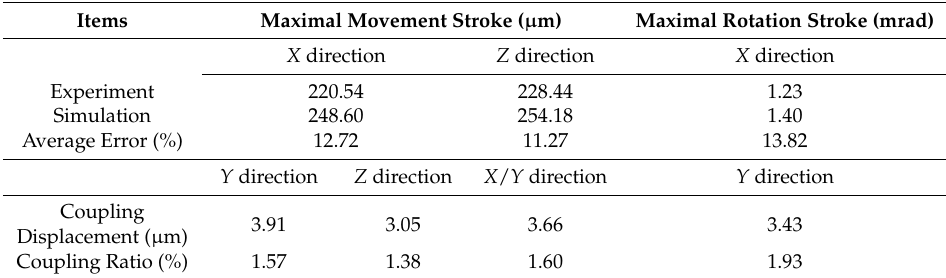
Figure 13. Simulated and experimental results of the compliant platform: ( a ) Output displacement in the X direction; ( b ) experimental coupling displacement in the Y and Z direction; ( c ) output displacement in the Z direction; ( d ) experimental coupling displacement in the X direction; ( e ) output angle around the X direction; ( f ) experimental coupling displacement in the Y direction. Table 3. Analysis results of the compliant platform.